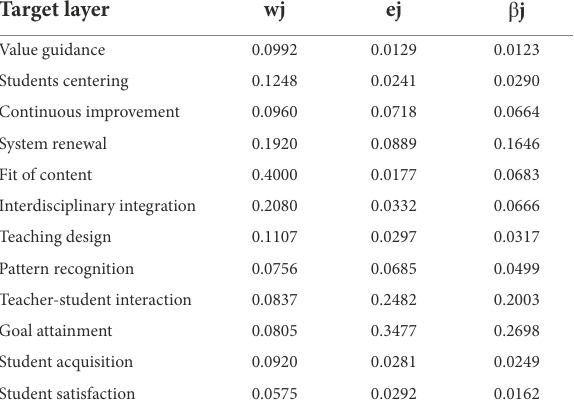
TABLE 6 Comprehensive weights of various indicators of undergraduate course quality